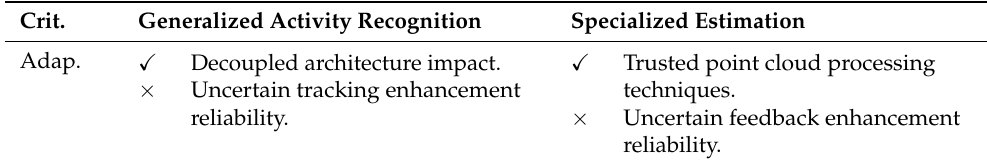
Table 2. A comparison of sensing methodologies explored for the enhancement of tracking reliability in a mmWave tracking